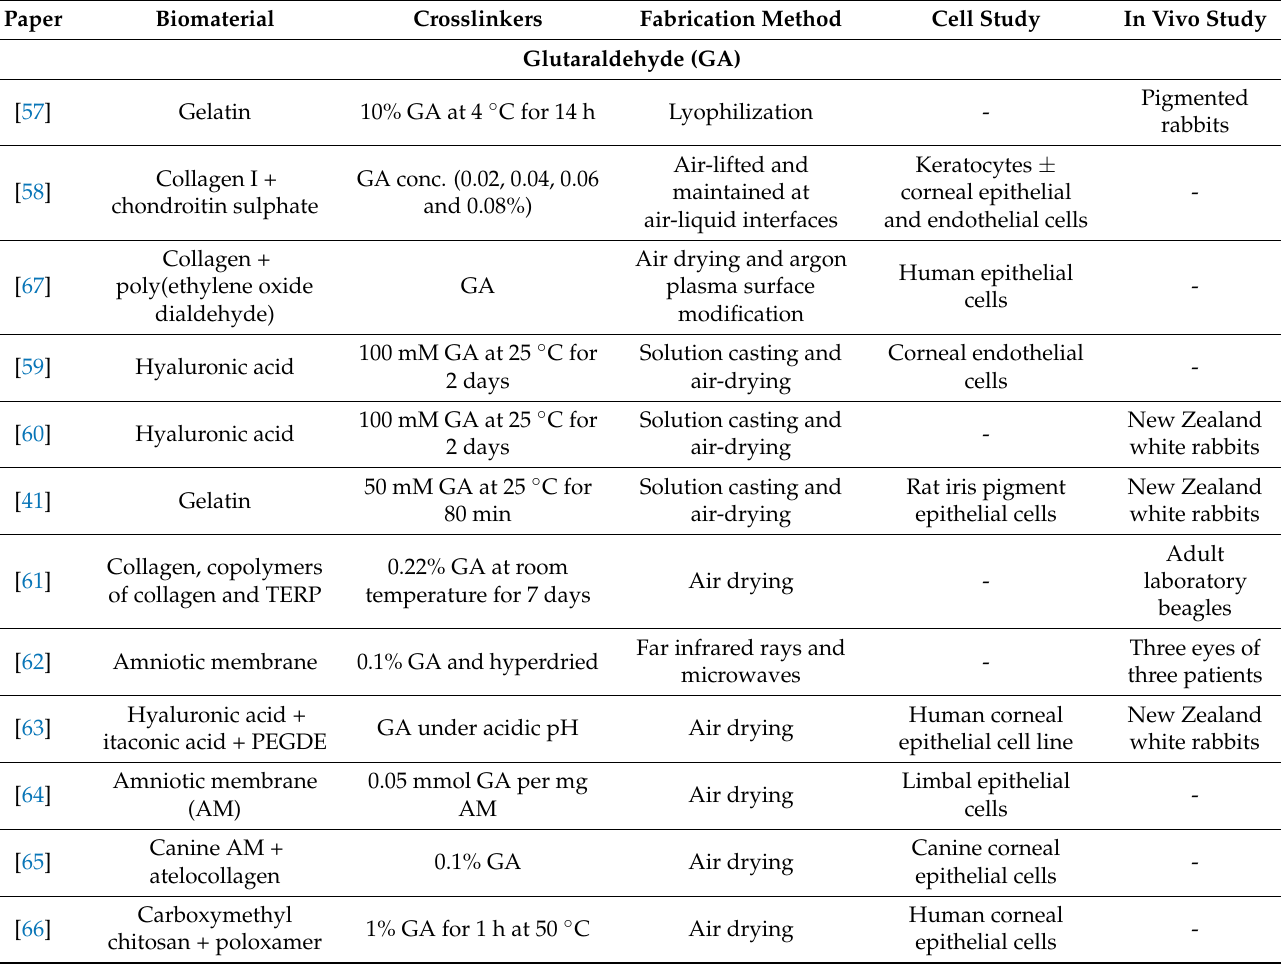
Table 1. Complete details of the different crosslinkers used in corneal regeneration to synthesize corneal hydrogels identified in this